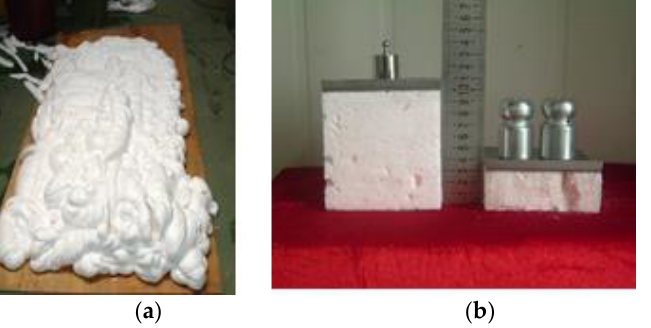
Figure 3. Foaming performance of mixed HASF-2/20 and DN-1. ( a ) Expansion effect and ( b ) solidified foam.